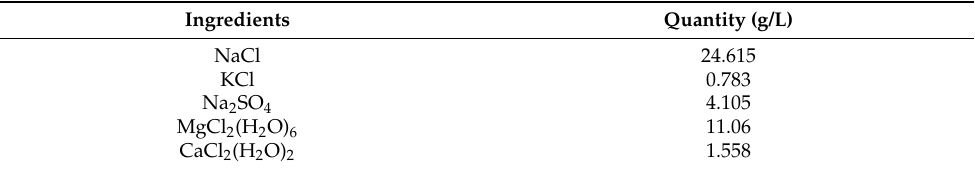
Table 1. Composition of artificial seawater.